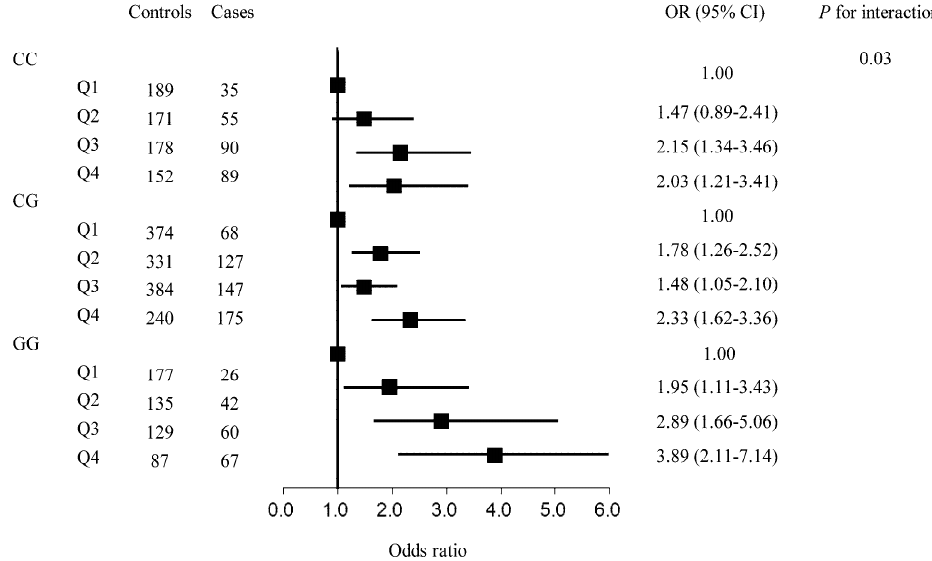
Figure 2. The association between carotid intima-media thickness (in quartiles) and large artery atherosclerosis ischemic stroke subtype stratified by rs2910164 genotype. Results were adjusted for age (continuous), sex (male, female), educa- tional levels (less than primary school, primary school, middle school, high school, college and above, missing), body mass index (continuous), alcohol consumption (current, former, never, missing), smoking status (current, former, never, miss- ing), type 2 diabetes (yes/no), hypertension (yes/no), and coronary heart disease (yes, no, missing).